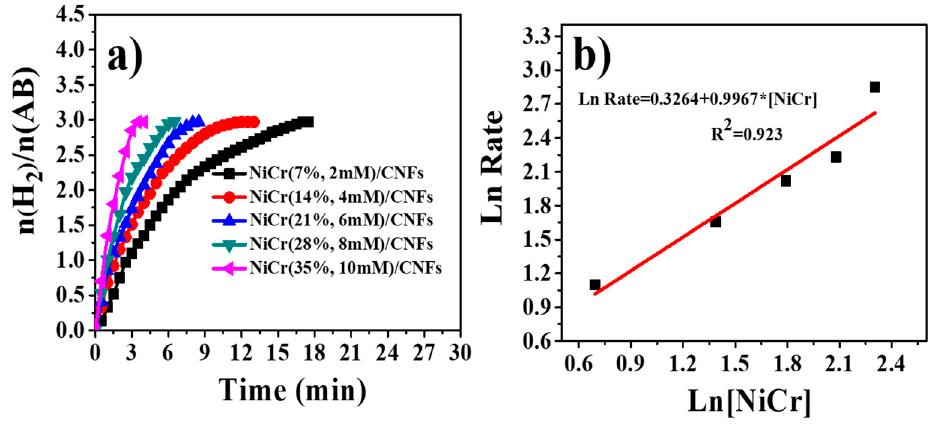
Figure 6. Effect of [Cr 2 Ni 3 ] (15 wt% CrAc) on H 2 gas generation from hydrolytic dehydrogenation of AB (100 mM) at 25 °C ( a ) and ln rate vs. ln [Cr 2 Ni 3 ] ( b ).